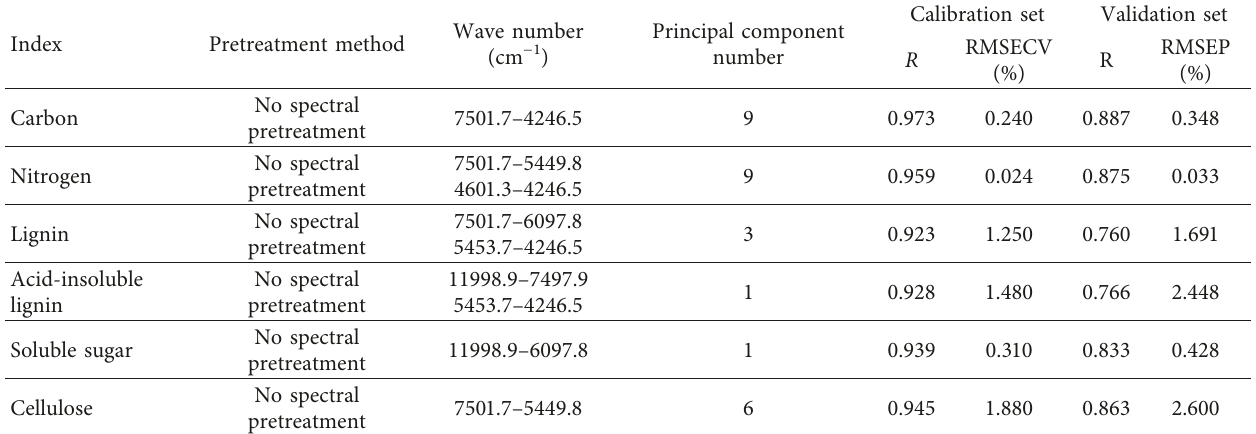
Table 5: The test result of the